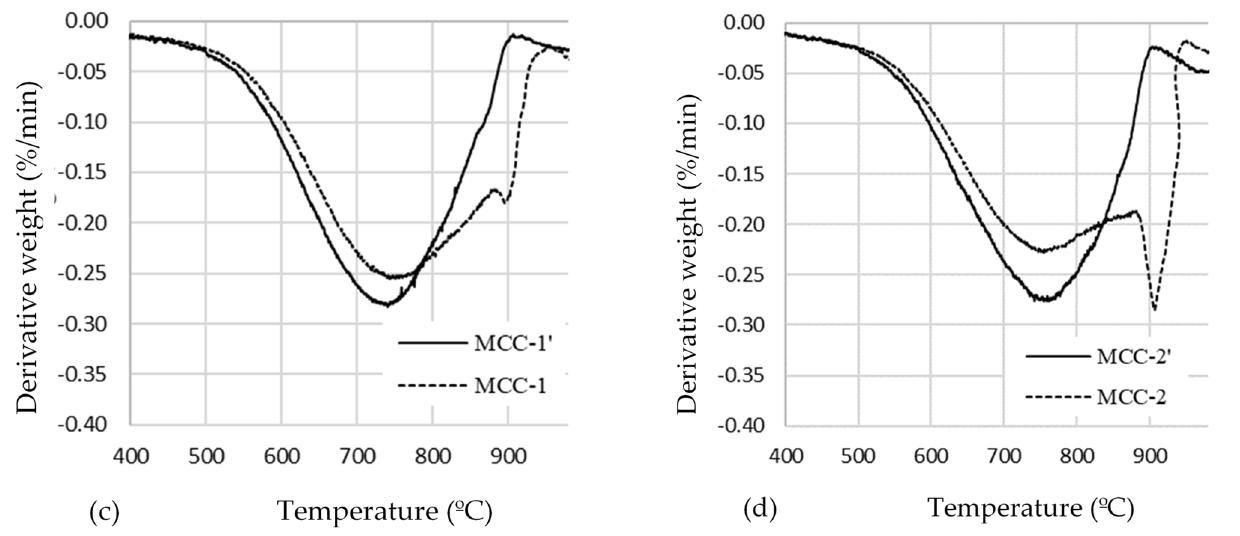
Figure 8. DTG curves of K 2 CO 3 and castable powder mixtures: ( a ) a mix without GQS CC-1 ′ and with GQS CC-1; ( b ) a mix without GQS CC-2 ′ and with GQS CC-2; ( c ) a mix without GQS MCC-1 ′ and with GQS MCC-1; ( d ) a mix without GQS MCC-2 ′ and with GQS MCC-2.